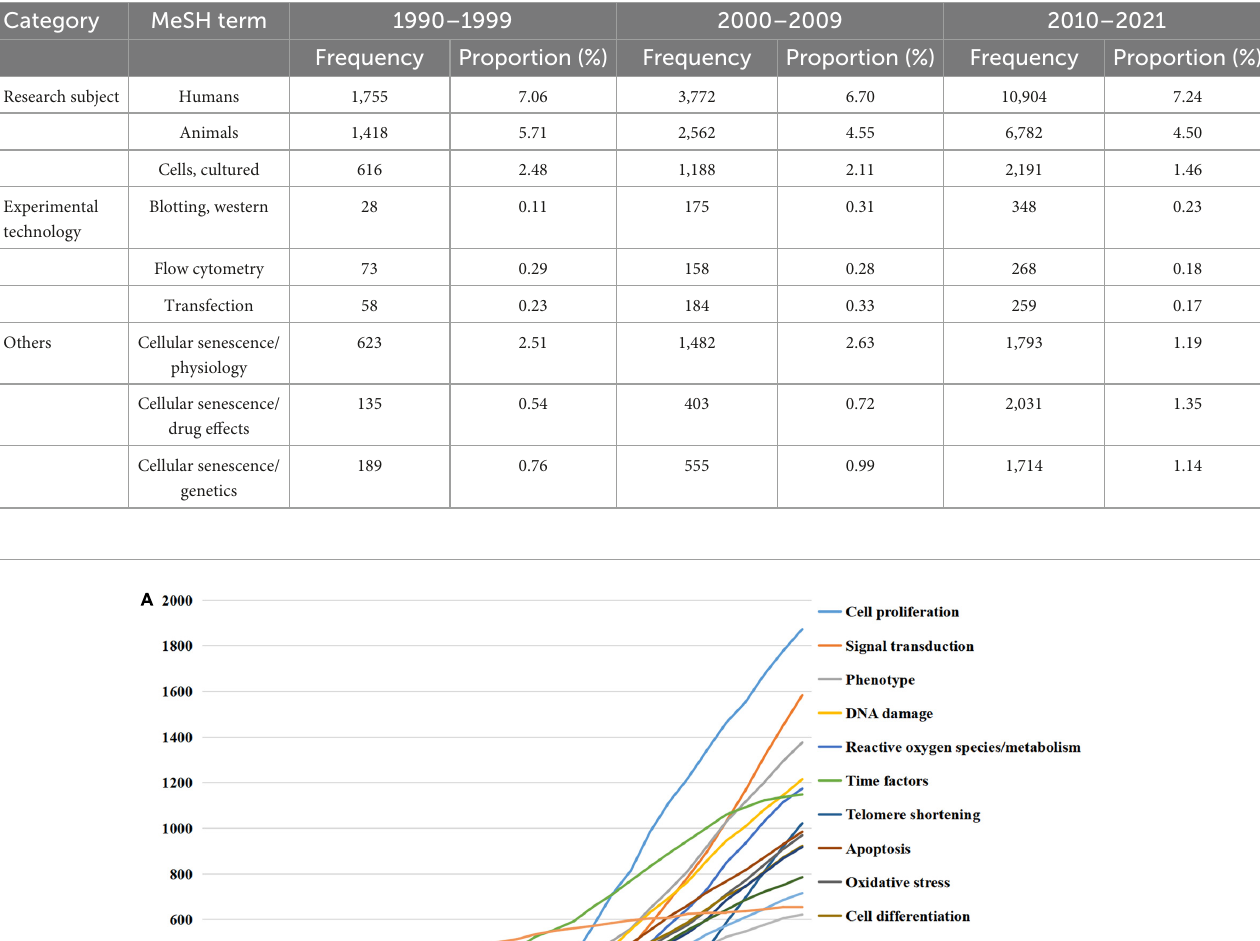
TABLE 2 Top three medical subject headings (MeSH) terms of each category.